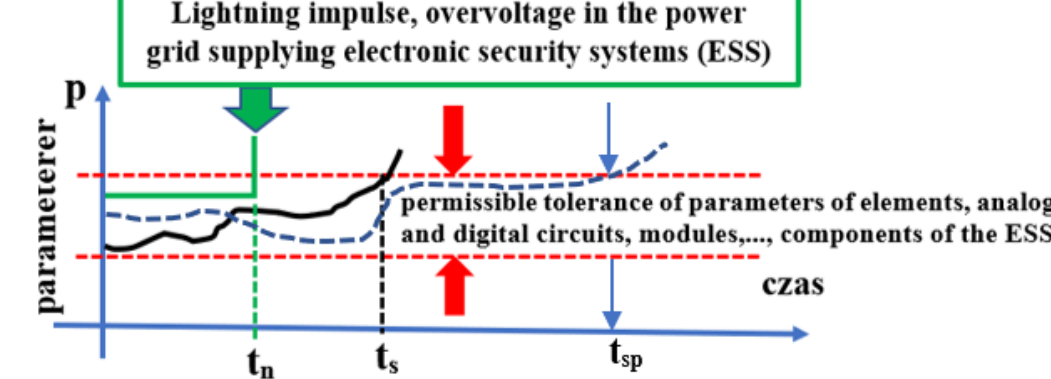
Figure 6. Continuous or step-wise change in the p parameters of FAS elements, systems, modules or devices, impacted by environmental changes, where: t s —damage time in the case of so-called ageing changes related to operation time, t n —time to damage upon pulsed actions causing unfit- ness—e.g., supply grid overvoltage, occurrence of an atmospheric discharge pulse, t sp— time to dam- age in the event of so-called ‘ageing changes’ related to operation time under favorable external environmental conditions.